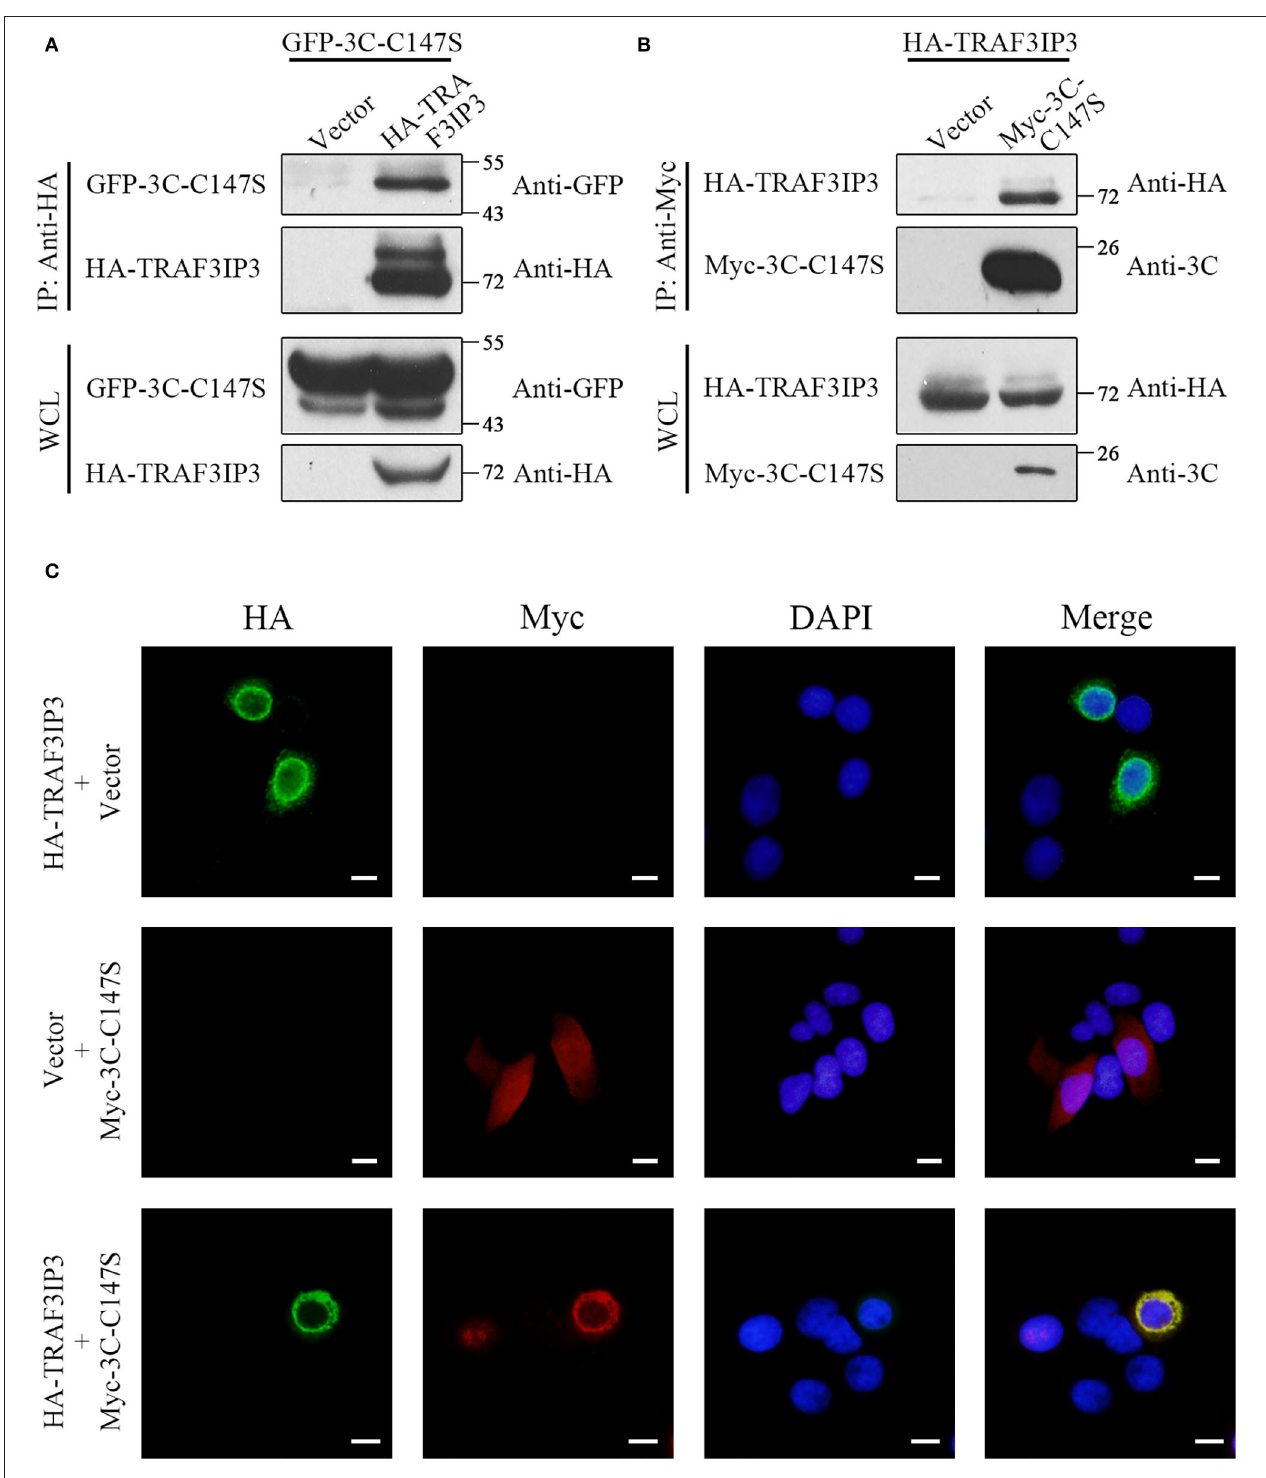
FIGURE 1 | TRAF3IP3 interacts with EV71 3C pro . (A) HEK293T cells were co-transfected with GFP-3C-C147S and HA-TRAF3IP3. Cells were harvested 48h after transfection and co-immunoprecipitated using anti-HA antibodies, and protein interactions were detected using Western blotting. WCL, whole-cell lysate. (B) HEK293T cells were co-transfected with HA-TRAF3IP3 and Myc-3C-C147S. Anti-Myc antibodies were used for co-immunoprecipitation, and other operations were the same as in (A) . (C) HA-TRAF3IP3 or Myc-3C-C147S were transfected into HeLa cells. 48 h later, the cells were fixed and protein subcellular localizations were observed using immunofluorescence. Scale bars = 10 µ